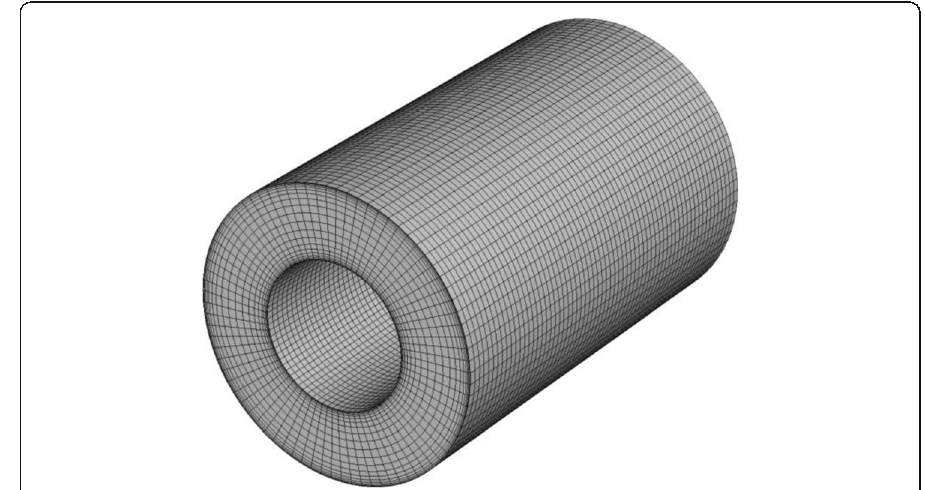
Fig. 2 Computational mesh for the p-refinement study for the Taylor-Couette